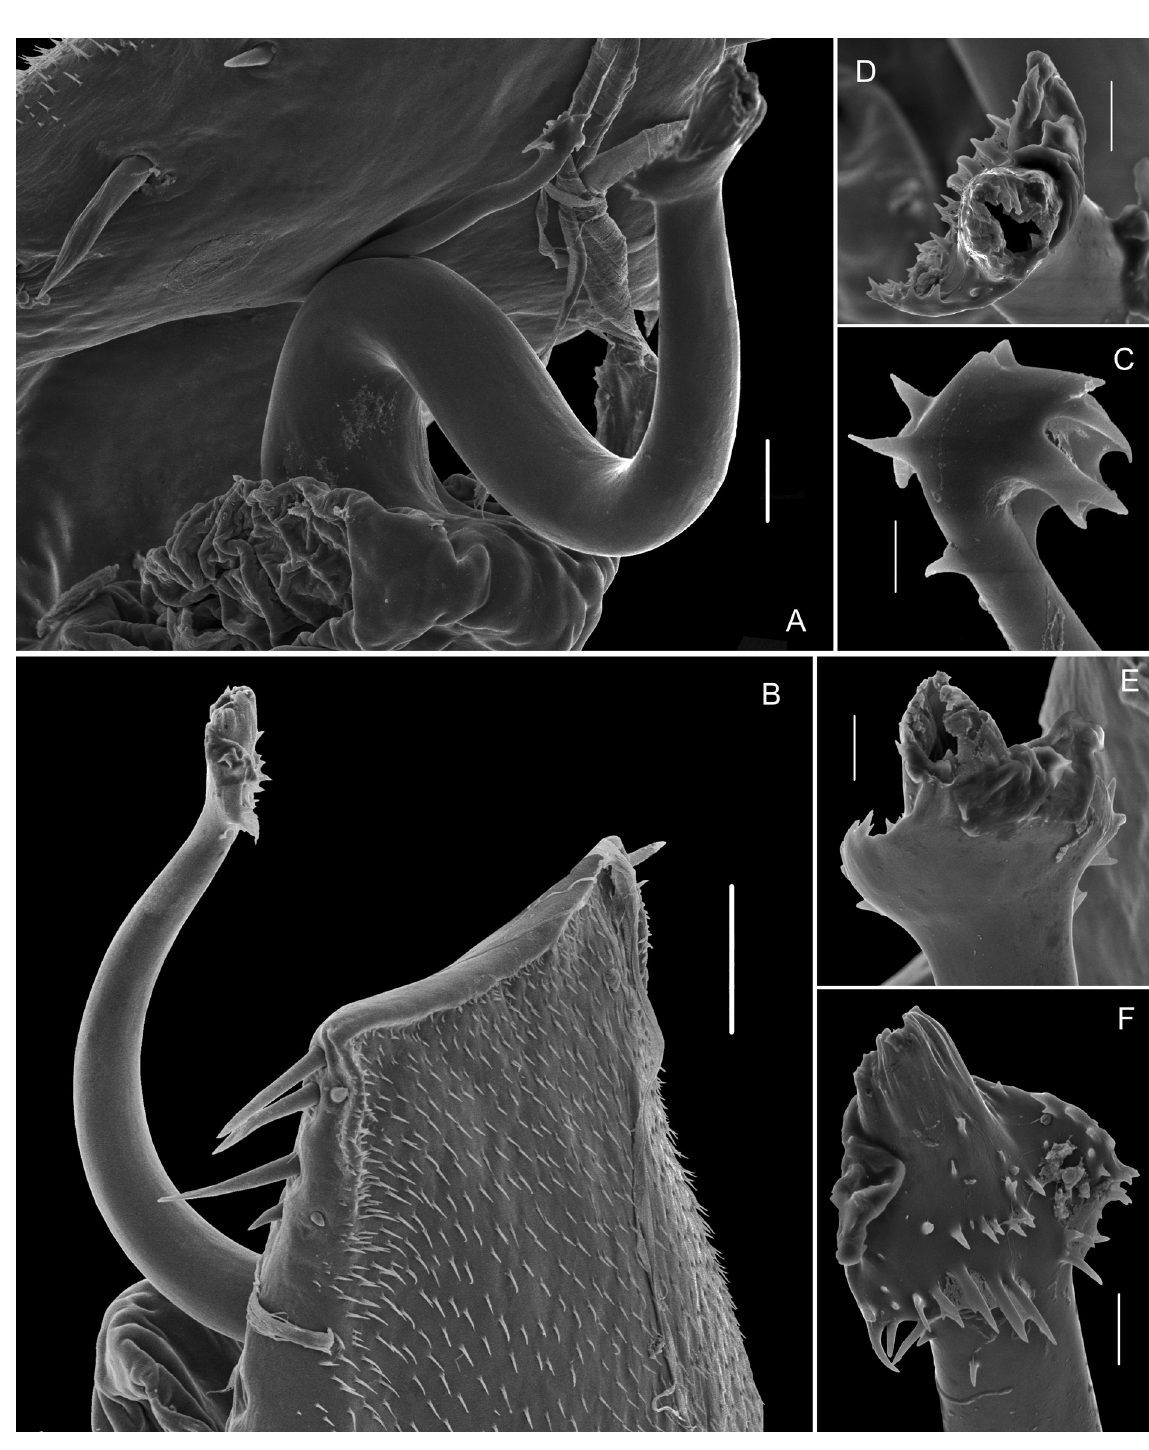
Fig. 9. Amazochroma pedroi gen. et sp. nov. (MNRJ 2352). ♂, genitalia, diverse details. A . Stylus, dorso-lateral view, showing stunted ventral process and small flabellum. B . Lateral view, also showing apex of ventral plate. C . Flabellum of ventral process, dorso-apical view. D . Stylus, apex, dorsal view. E . Same, apical view. F . Same, posterior view. Scale bars: A = 20 μ m; B = 50 μ m; D–F = 10 μ m; C = 5 μ